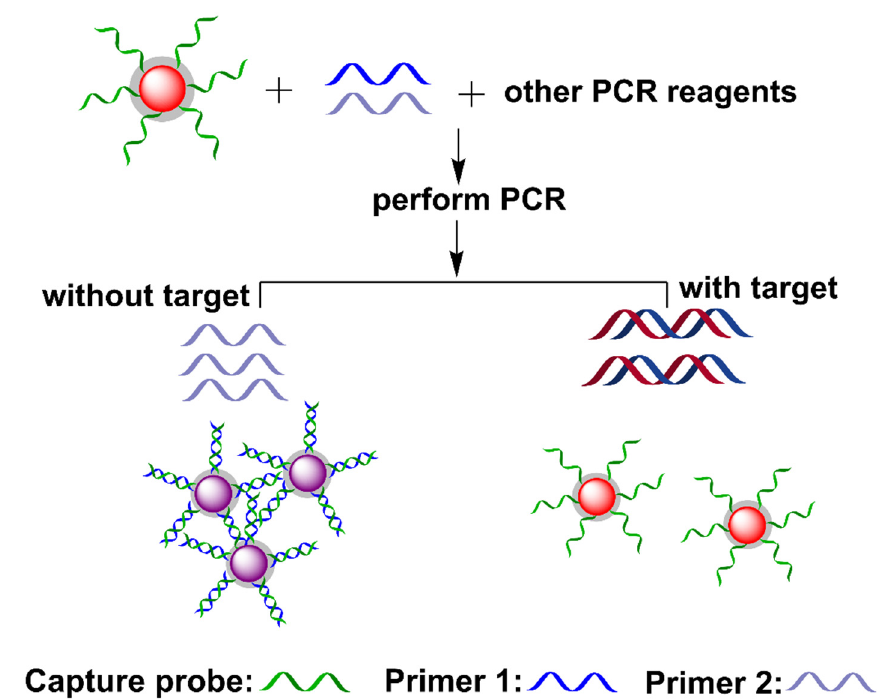
Figure 8. Schematic diagram of the one-step colorimetric PCR-based sensing platform. Adapted with permission from ref [86]. Copyright 2011 John Wiley and Sons.